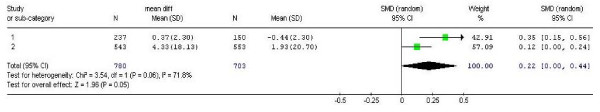
Meta-analysis of the effect of training on the attitude of general population in the integration program of mental health in PHC.